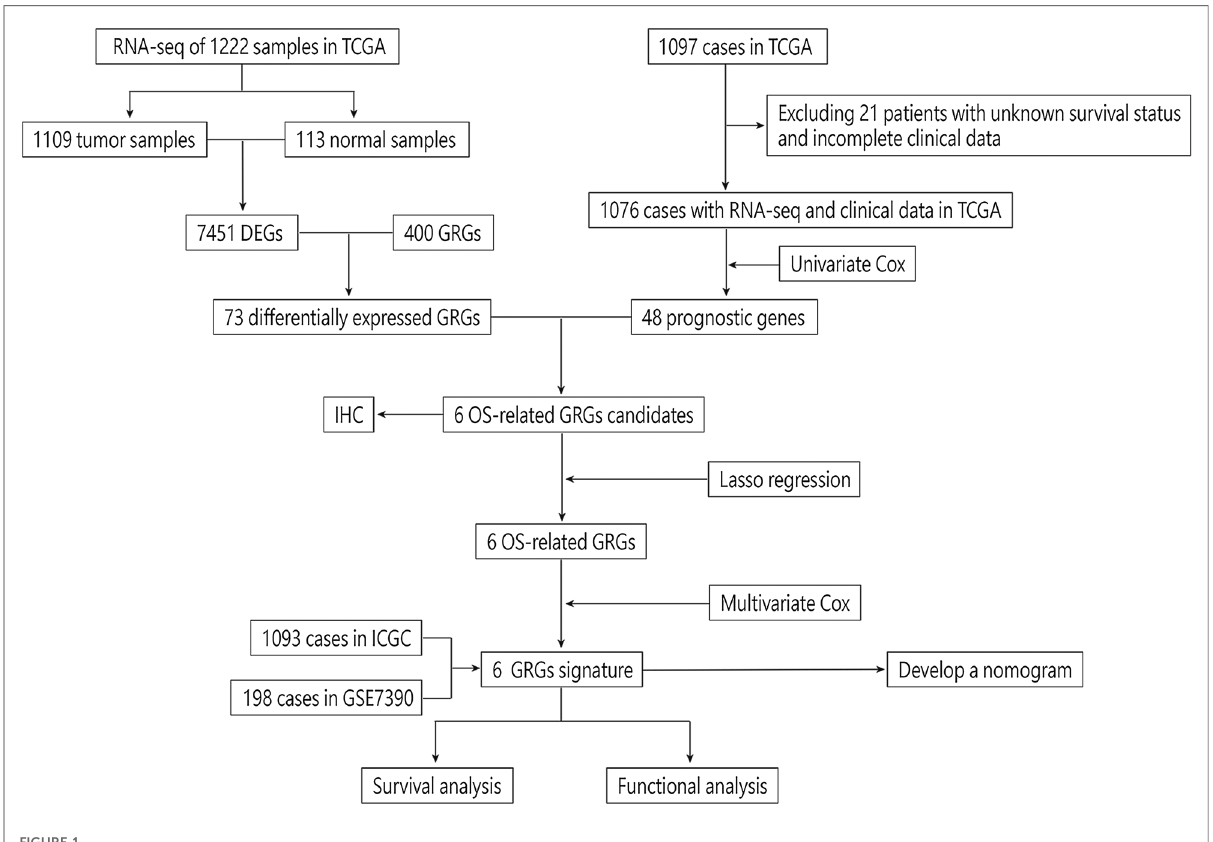
FIGURE 1 Flow chart of a GRG signature in BRCA